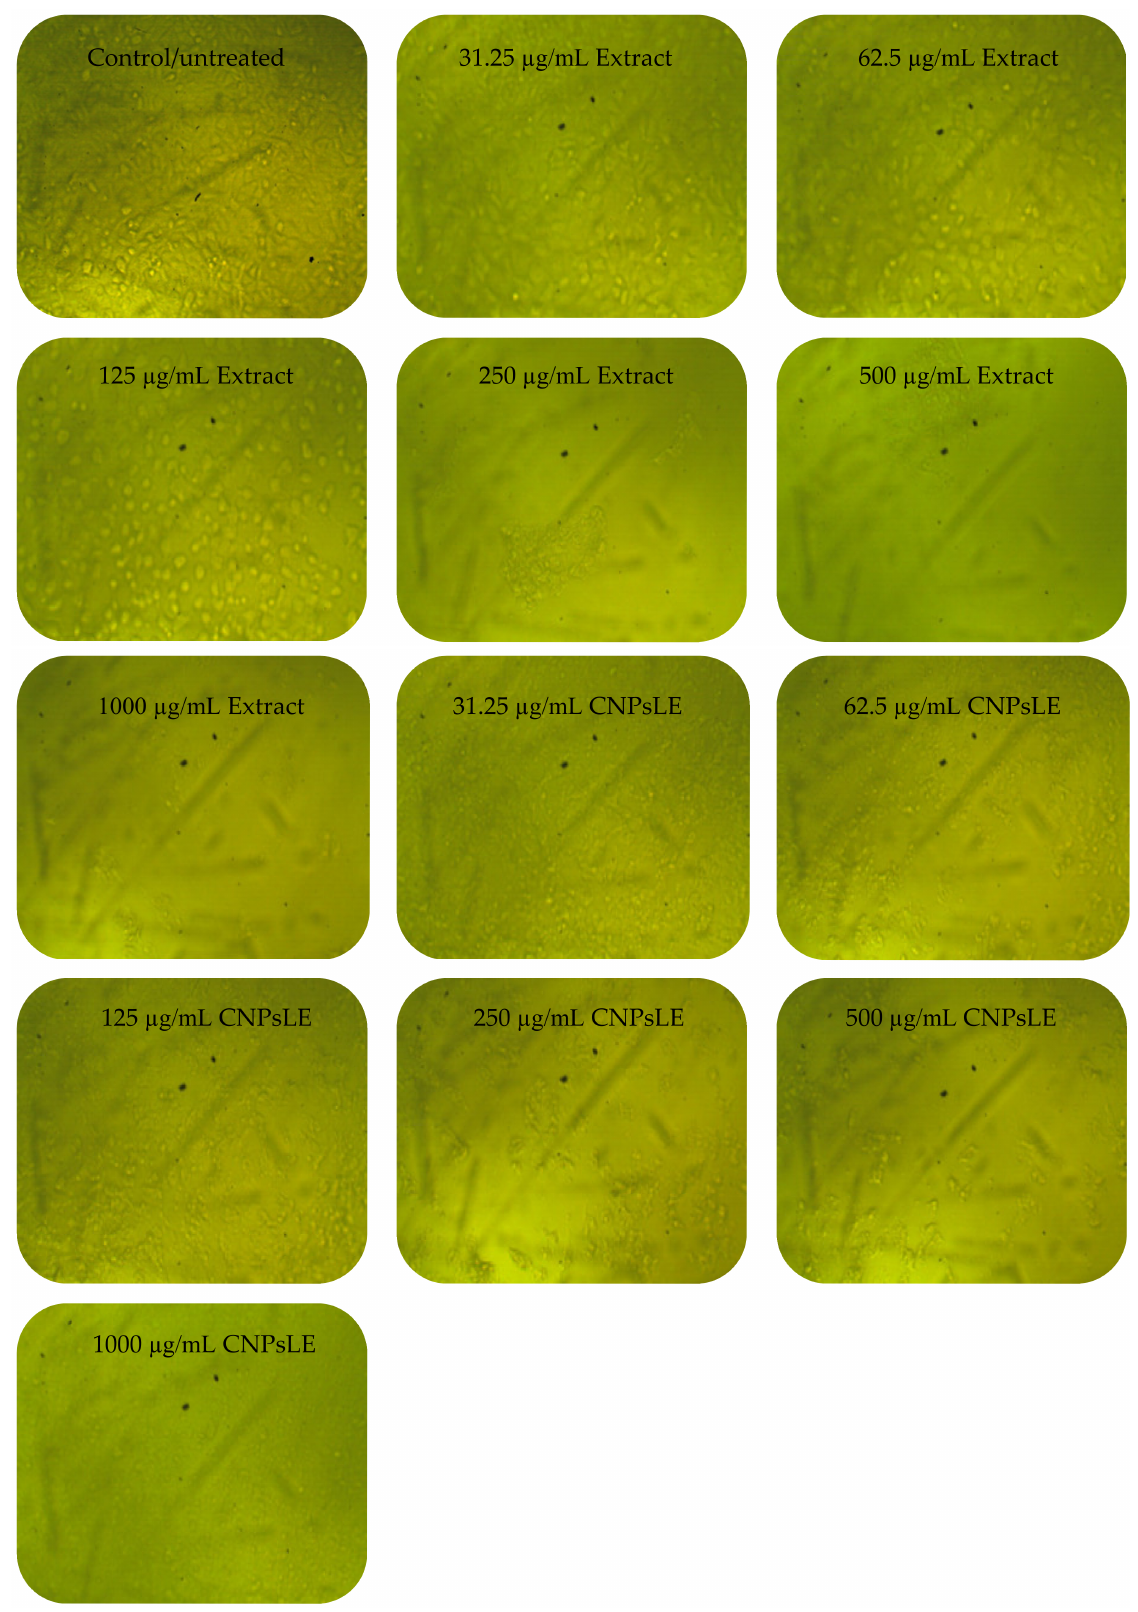
Figure 7. Images showing the cytopathic effects (CEP) of prostate cancer (PC3) cells treated with Artemisia judaica extract and Artemisia judaica extract loaded into chitosan nanoparticles (CNPsLE) at multiple